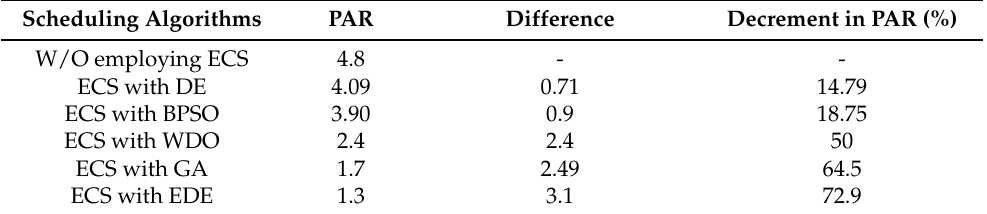
Table 12. Numerical results of PAR minimization evaluation after scheduling noninterruptible appliances. Scheduling Algorithms PAR